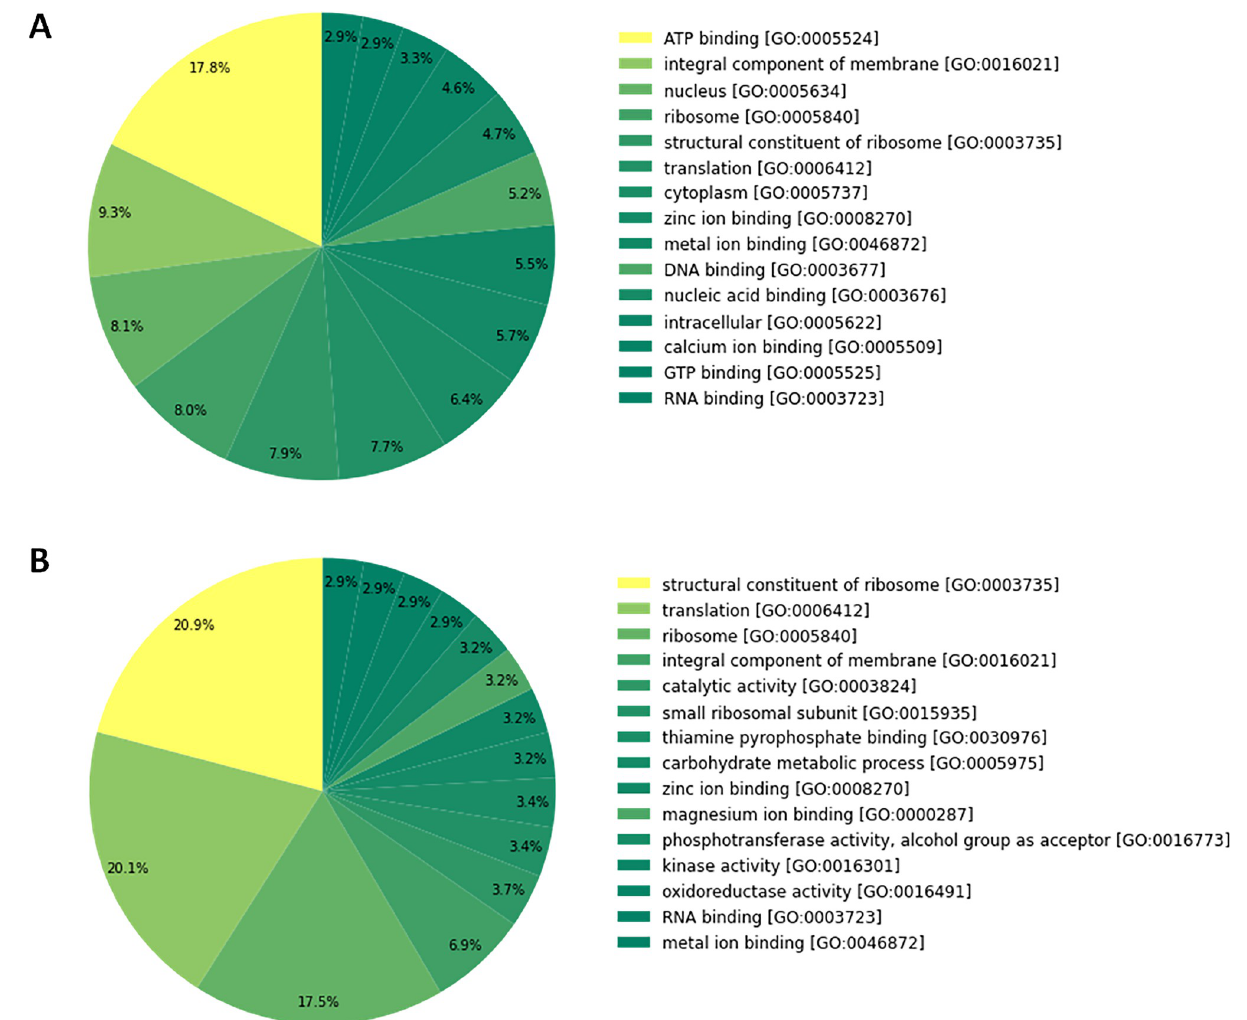
Fig 5. Top 15 gene ontology terms for transcripts differentially expressed in anhydrobiotic H . indica (A) Upregulated (B) Downregulated.